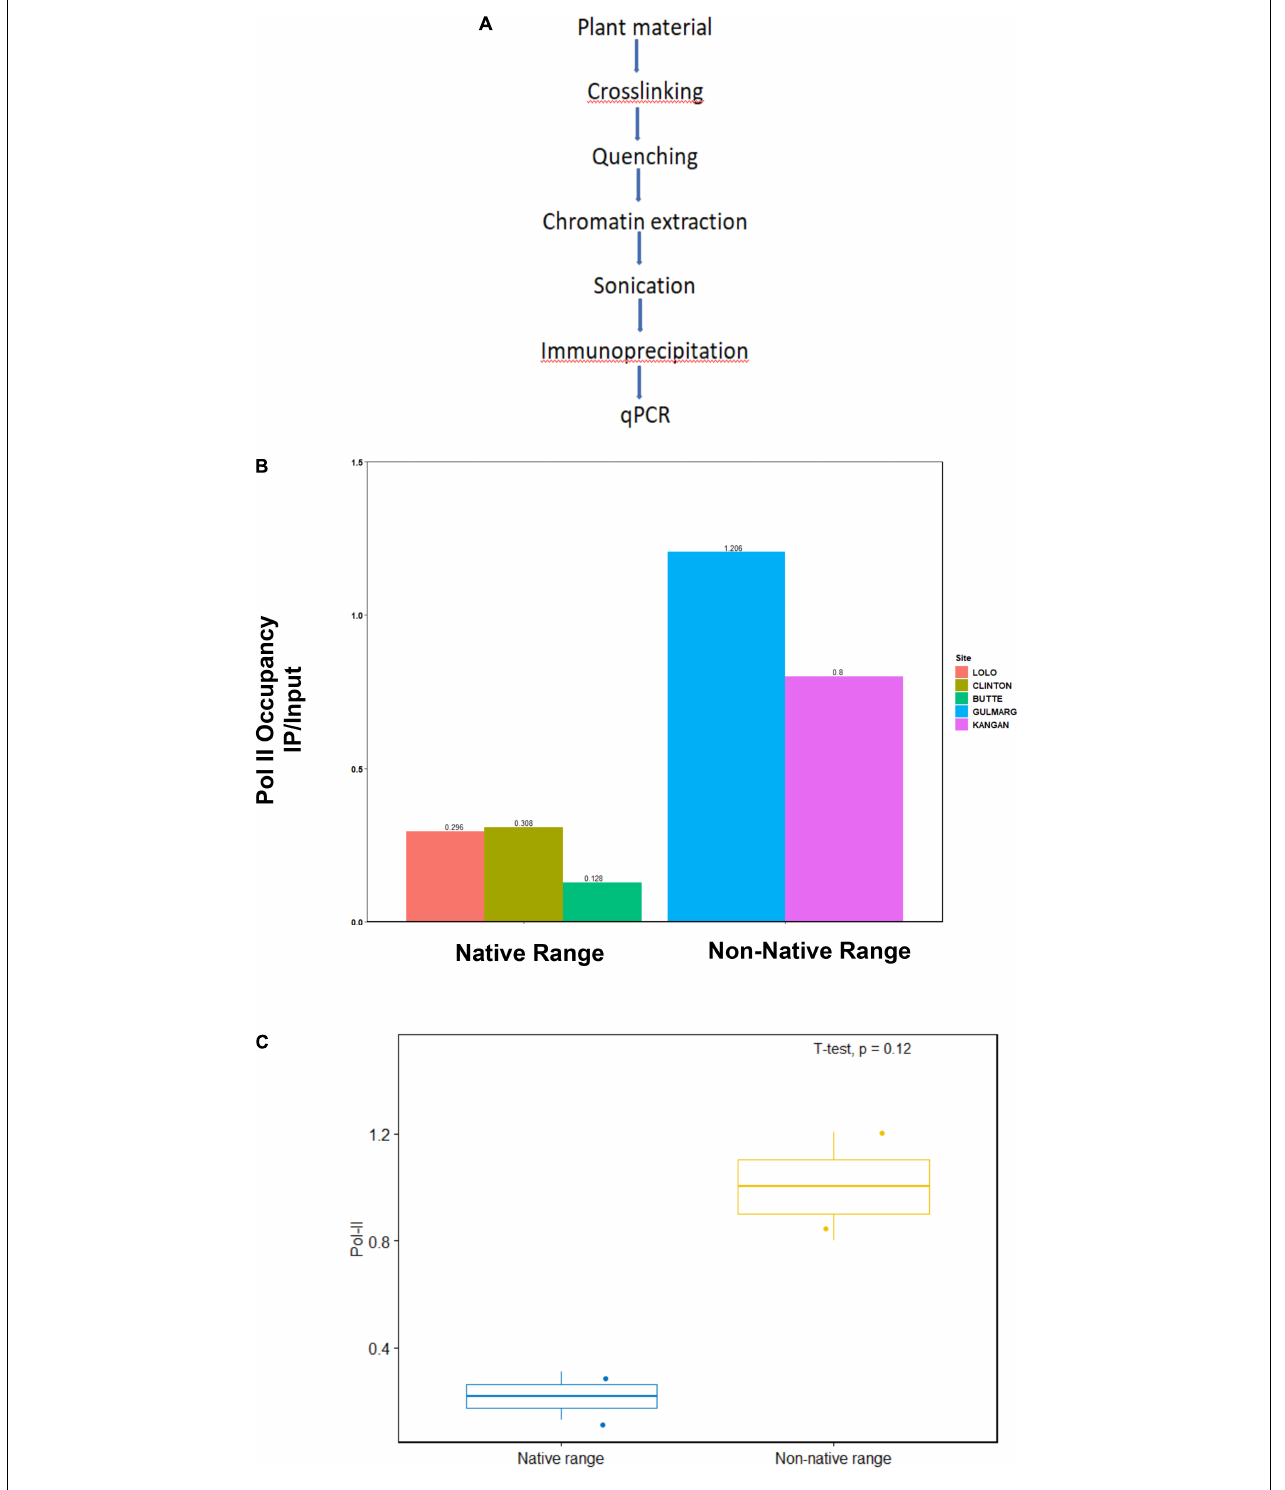
FIGURE 2 | Pol-II occupancy at ABC transporter genes in the native (North America) and non-native (Kashmir Himalaya) range plants. (A) The plant material was collected at different geographical locations as mentioned in “Materials and Methods” section. The DNA-protein interaction was cross-linked with a suitable cross-linking agent. Subsequently, the DNA was isolated, sonicated, and then subjected to immunoprecipitation using specific antibodies. (B) The bar graphs represent the RNA Pol-II occupancy at ABC transporter genes in native and non-native range plants. (C) RNA Pol-II occupancy at ABC transporter gene in the native and non-native range obtained using R software, n =